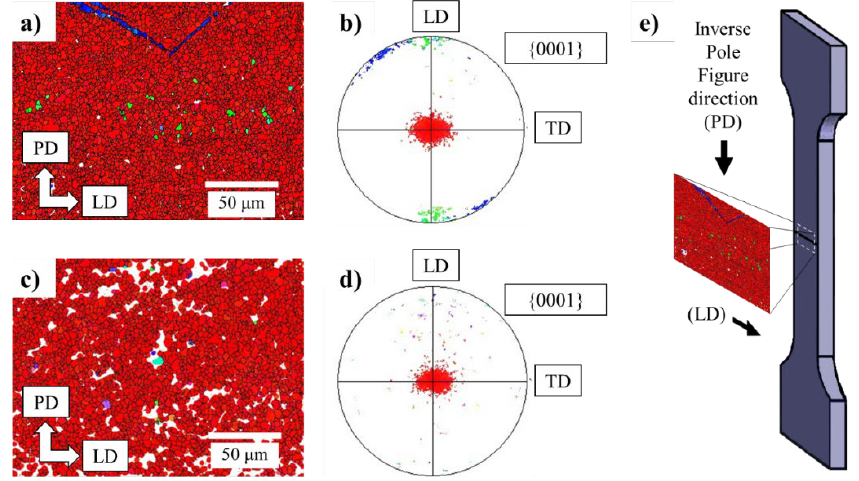
Figure 11. EBSD maps and associated pole figures of the central weld zones in ( a , b ) AZ91/AZ91 and ( c , d ) AZ91–2Ca/AZ91–2Ca welds, where PD is forging direction, LD is longitudinal direction, and TD is transversal direction. Both weld zones display extensive recrystallization and a strong basal texture perpendicular to the forging direction and ( e ) tensile loading